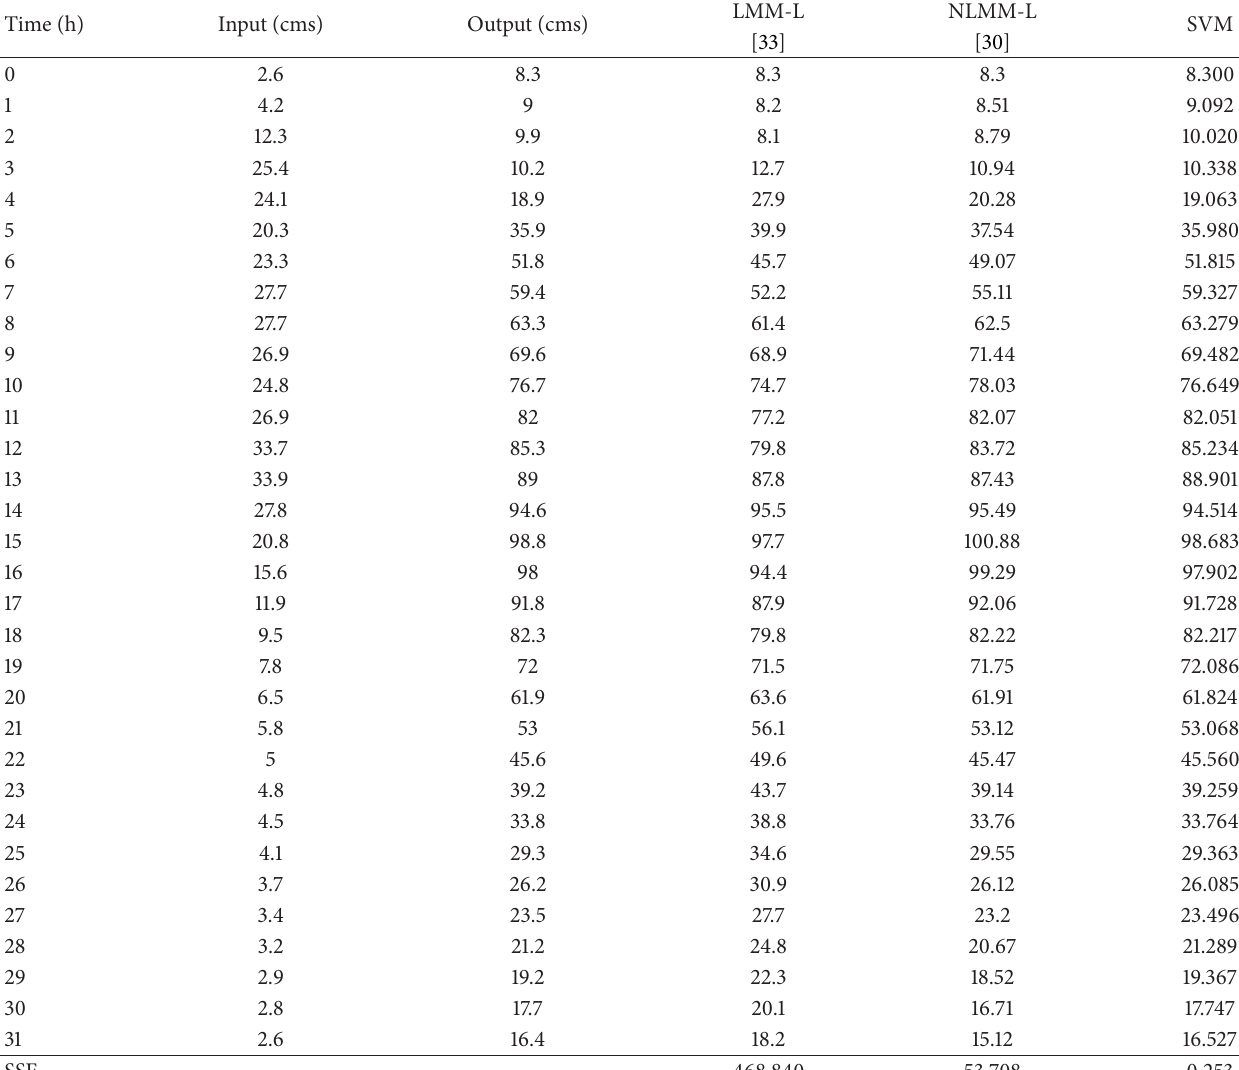
Table 3: Comparison of the observed and routed outflows for the River Wyre